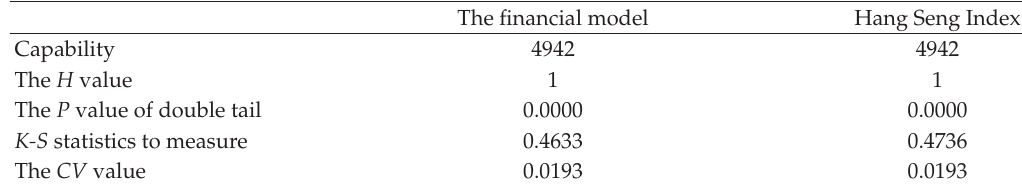
Table 1: The Kolmogorov-Smirnov